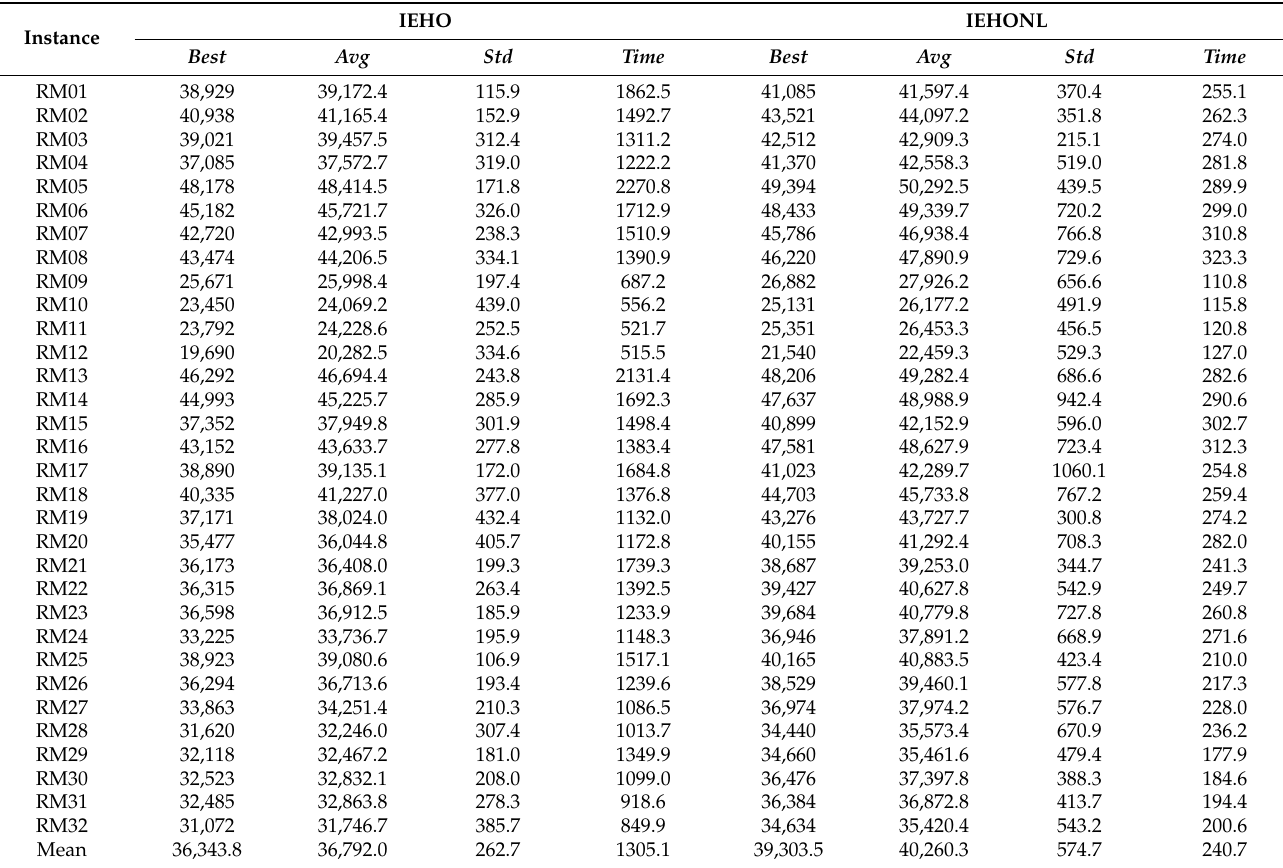
Table 7. Comparison results of IEHO and